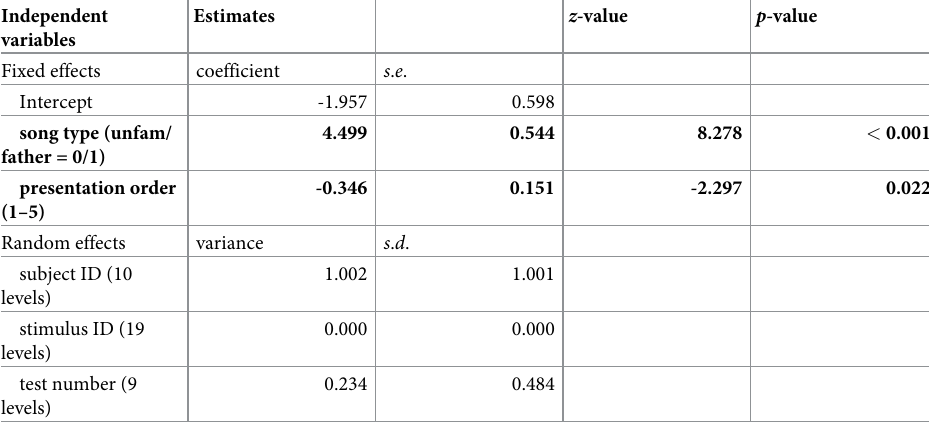
Table 1. Effect of song type on females’